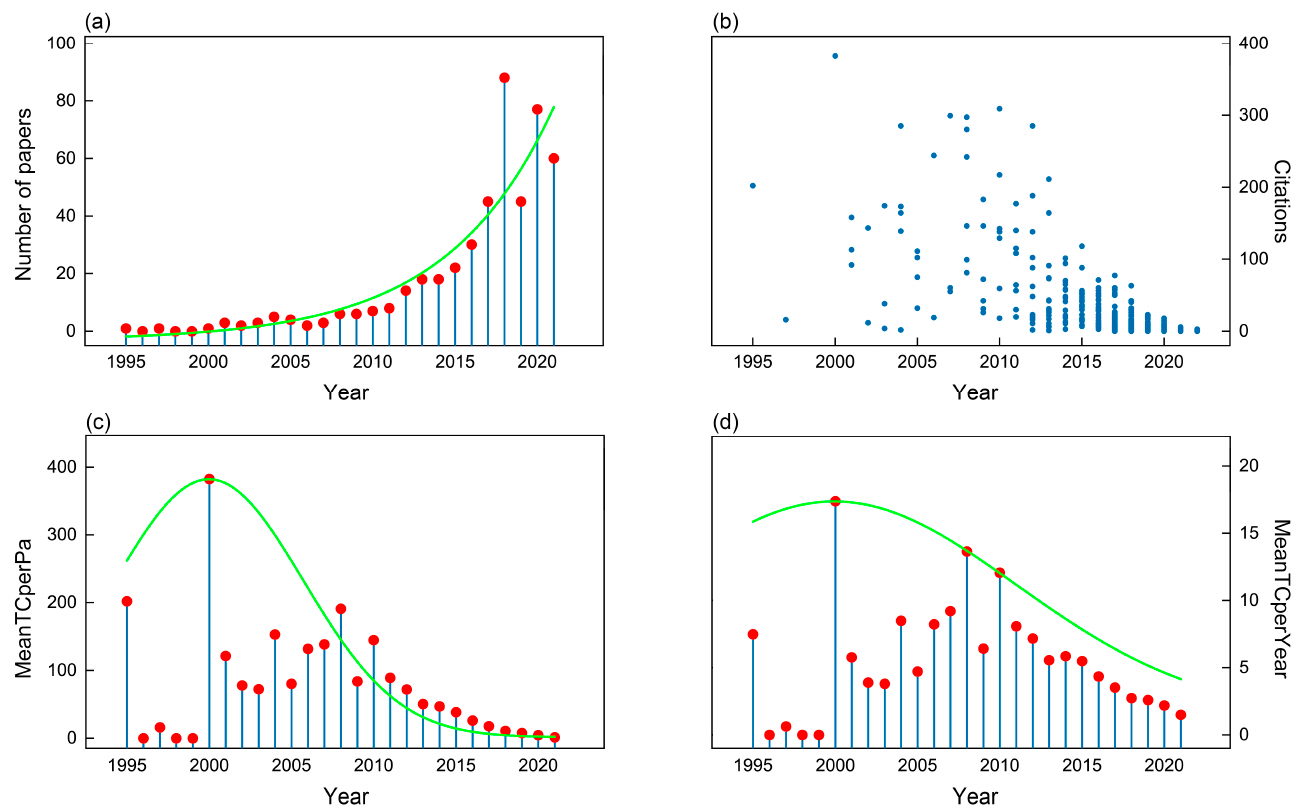
Figure 3. Contribution of community gardens research from 1995 to 2021, including ( a ) total publications, ( b ) number of citations given to each paper, ( c ) mean total citations per paper (MeanTCperPa), ( d ) mean total citations per year (MeanTCperYear). The green line indicates the trend of change.